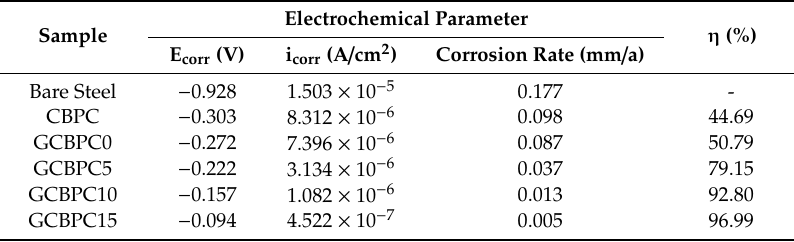
Table 5. Curing parameters based on the potentiodynamic polarization curves.